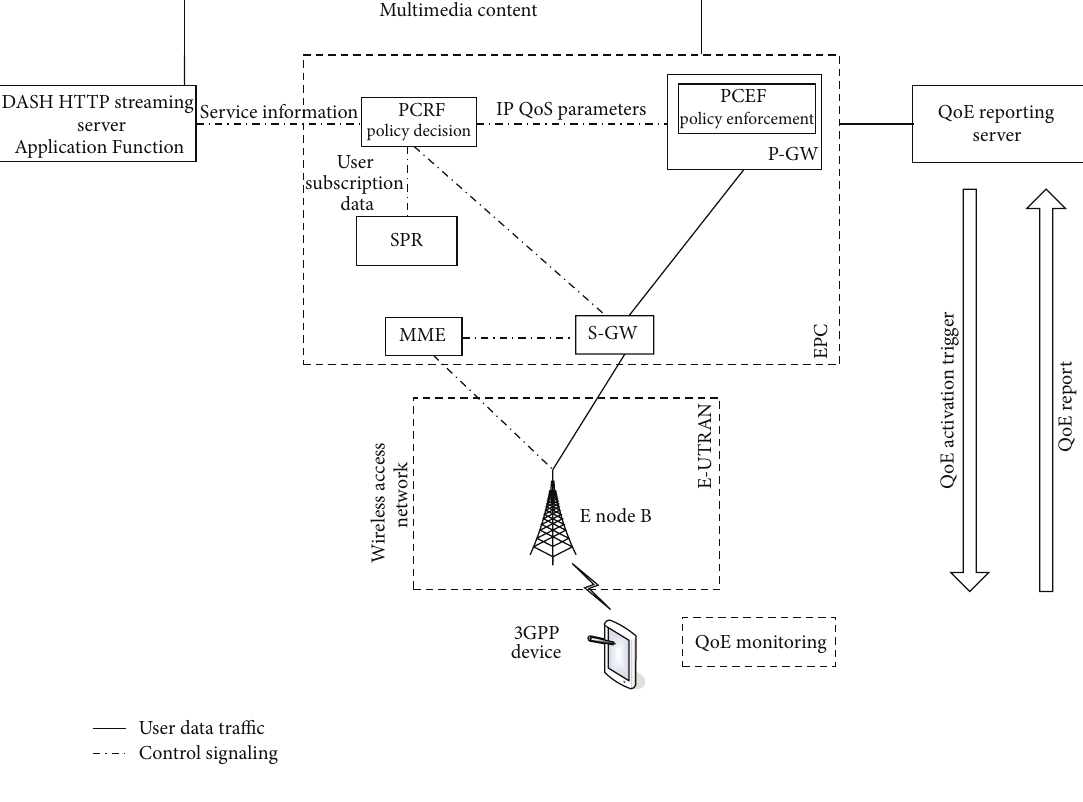
proposing seamless mobility management solutions was one of the key focus areas of the EU FP7 PERIMITER project [94] (available deliverables provide detailed insight into user- centric mobility